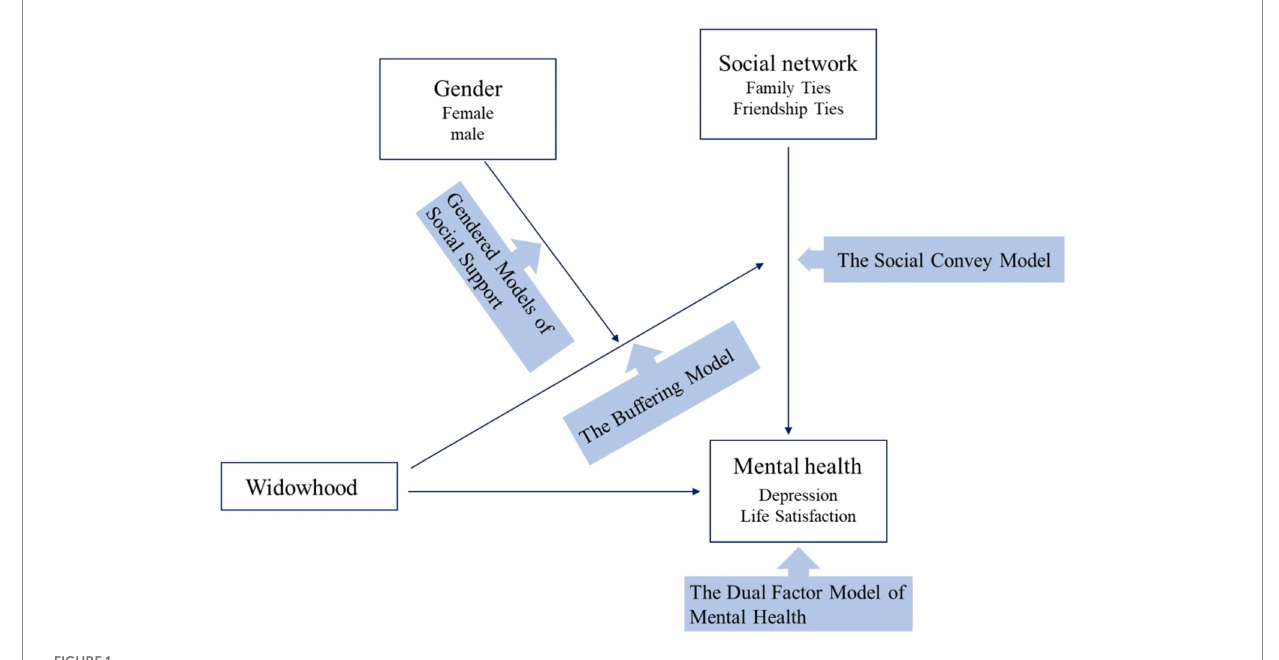
FIGURE 1 The research framework of the